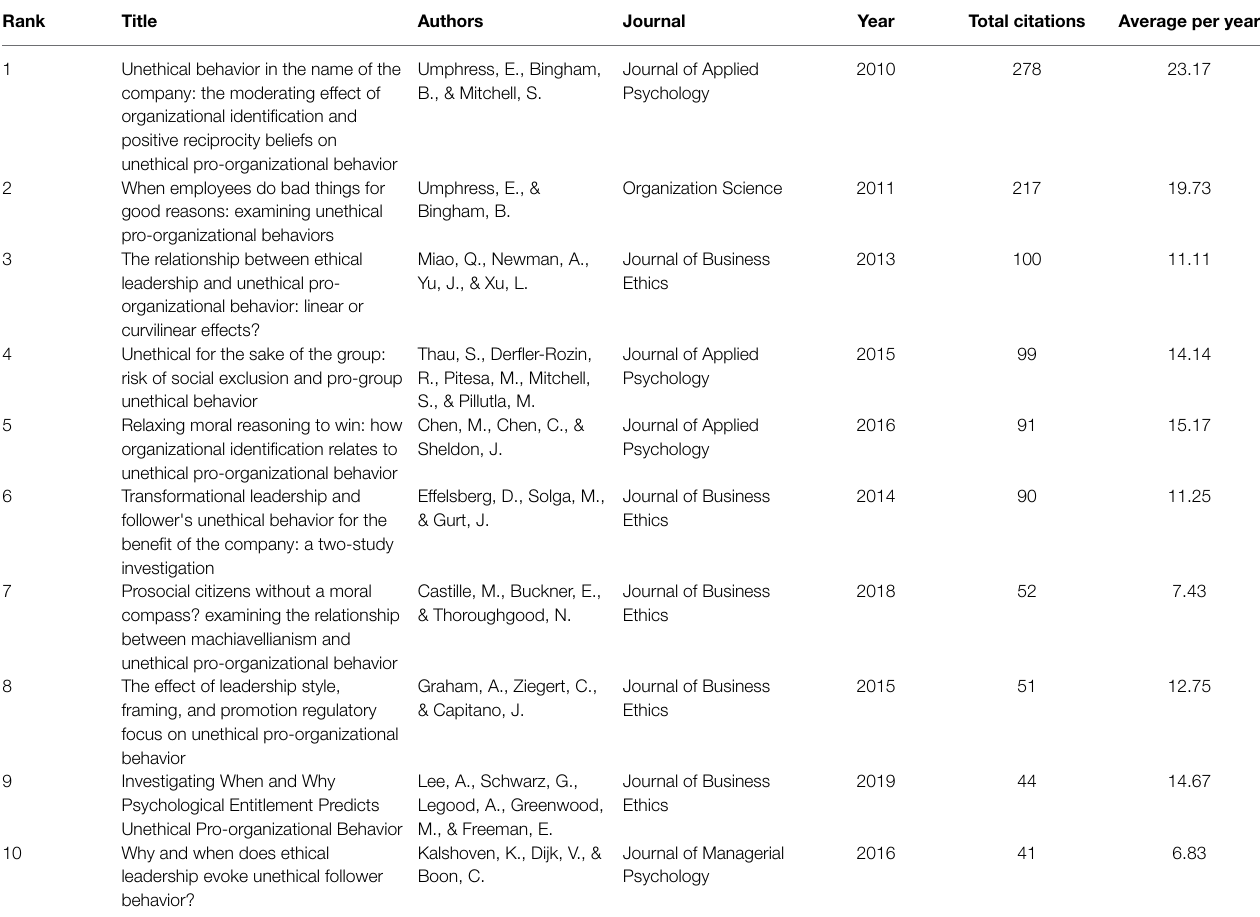
TABLE 1 | The top 10 most cited articles in UPB